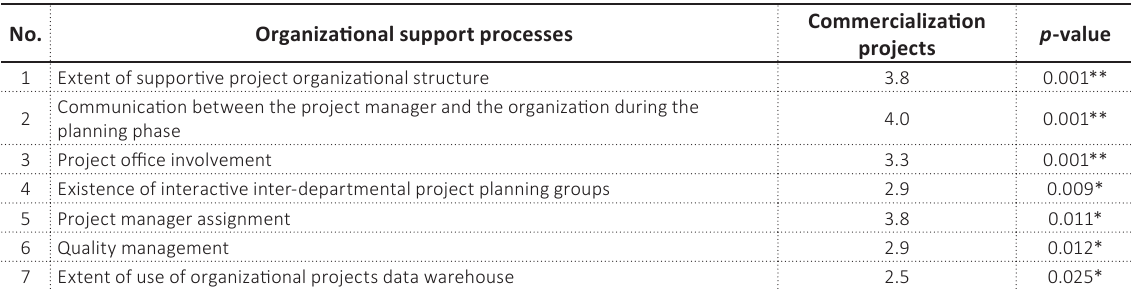
Table 3. Critical organizational support processes for commercialization projects